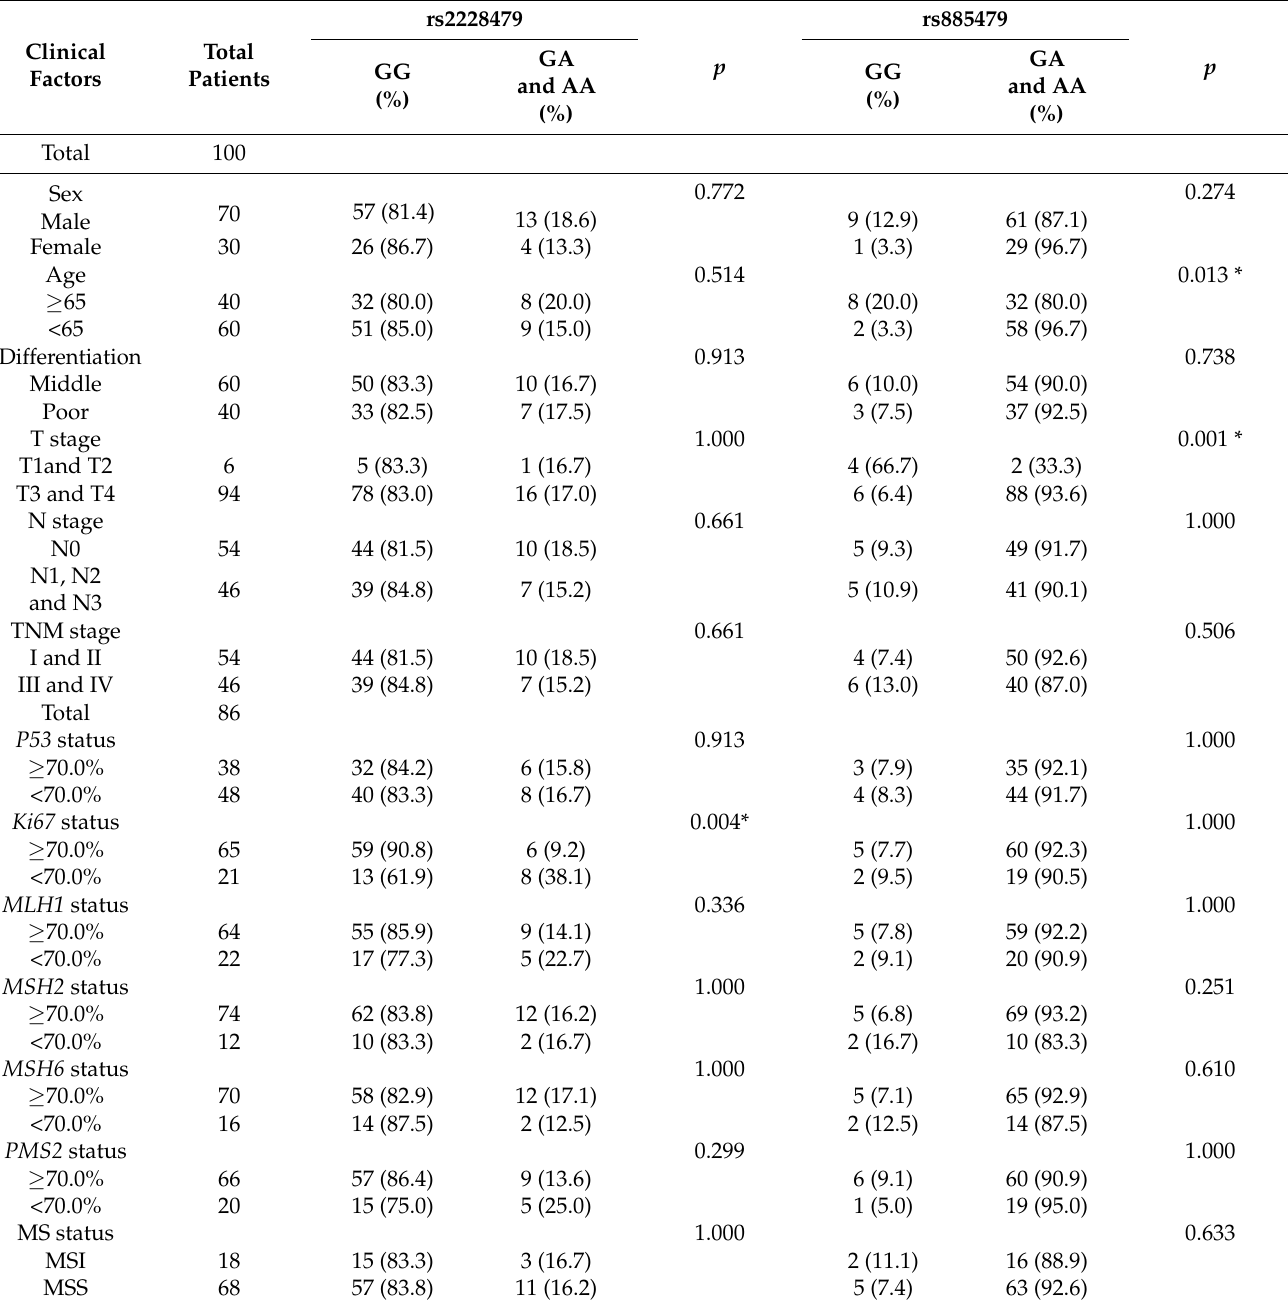
Table 2. Correlation analysis of MC1R SNPs and clinical